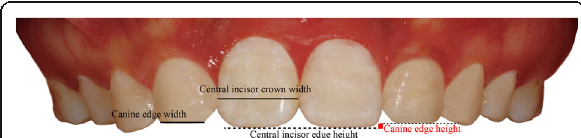
Fig. 1 The esthetically most pleasant (ranked as top 1) canine shape with the highest grades for the incisal width and height by all observers in the study. The canine edge width was based on the percentage of the width of the maxillary central incisor clinical